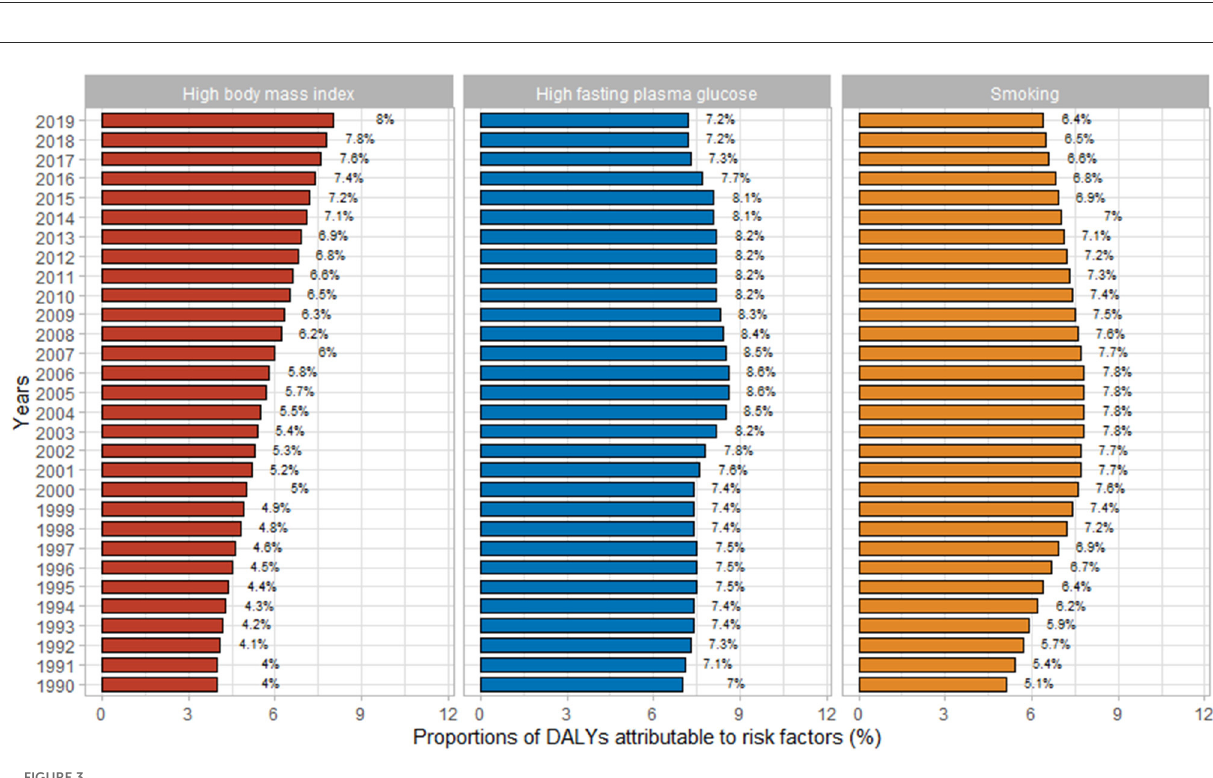
2044, an increase of approximately 176%. The number of deaths was estimated at 214,710 in 2019, increasing to 653,048 by 2044, an increase of approximately 204%. As can be observed from the figure, the predicted number of CFWD is slightly above the